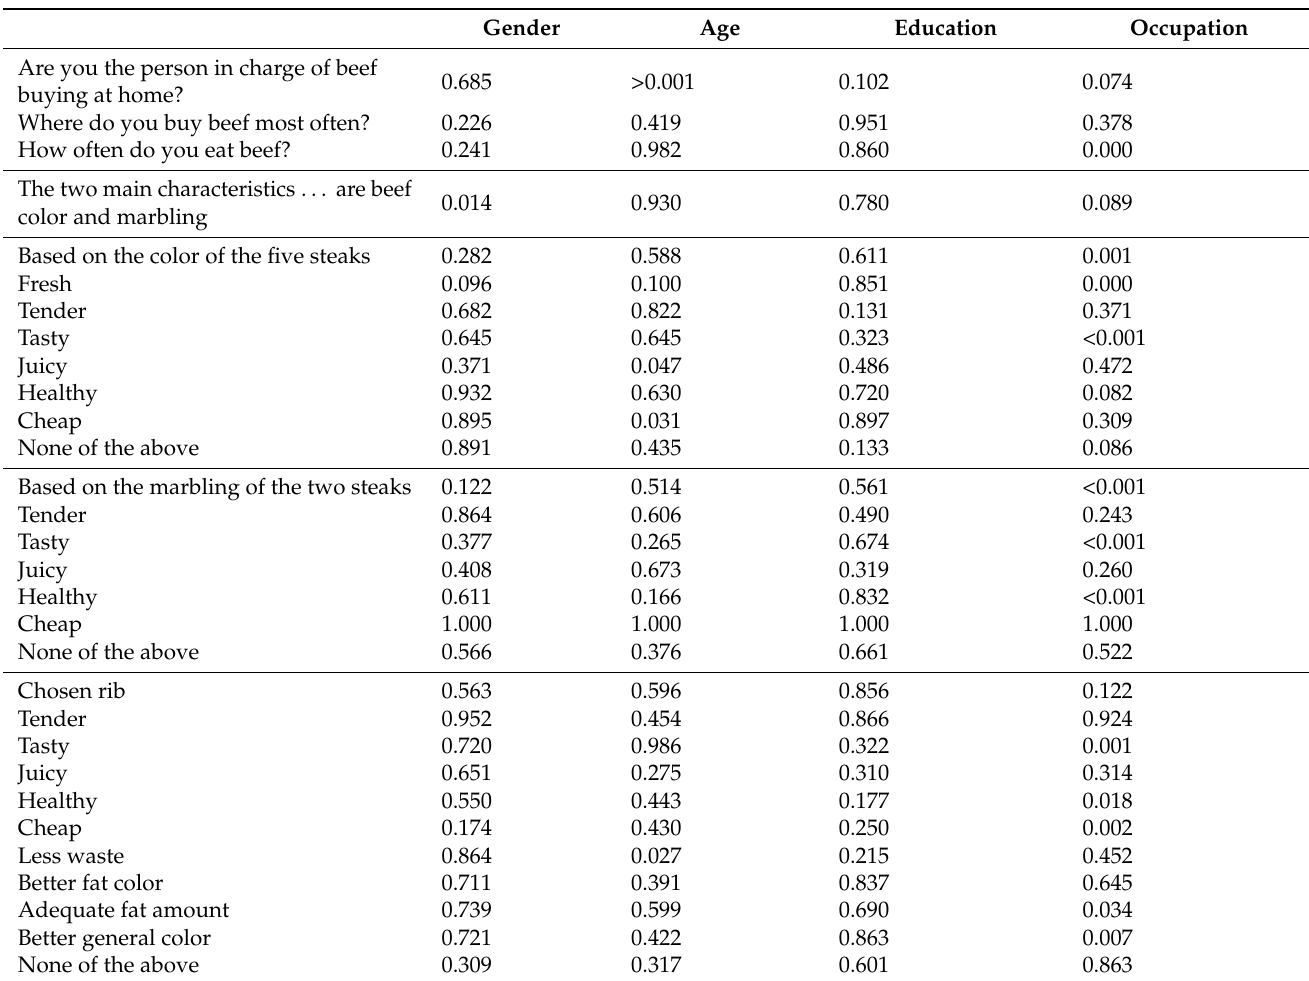
Table 4. Chi-square p -values for the Kruskal–Wallis test with socio-demographic variables (gender, age, education level and occupation) as the main